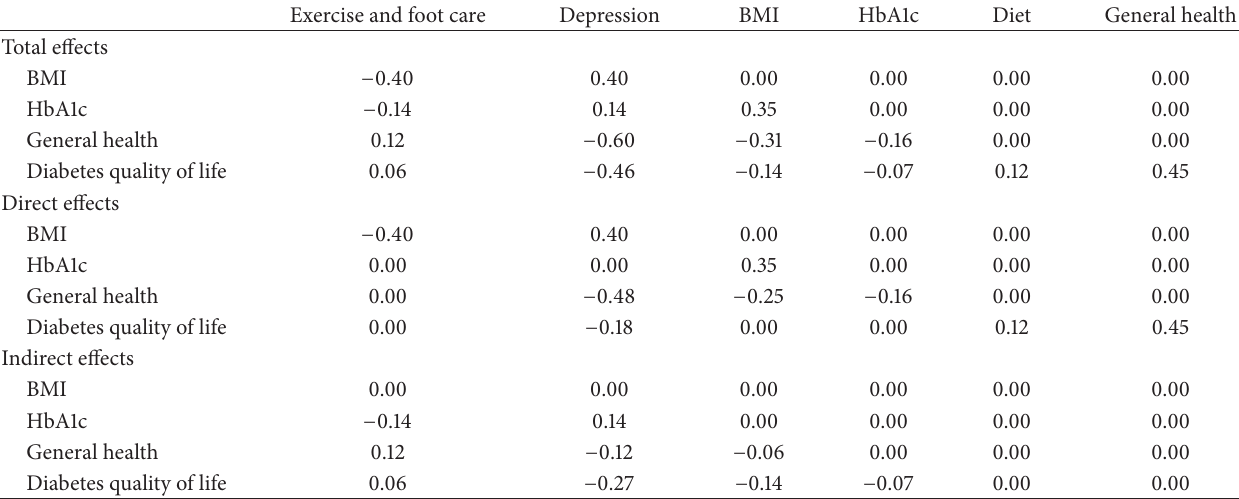
Table 5: Standardized total effects, direct effects, and indirect effects in